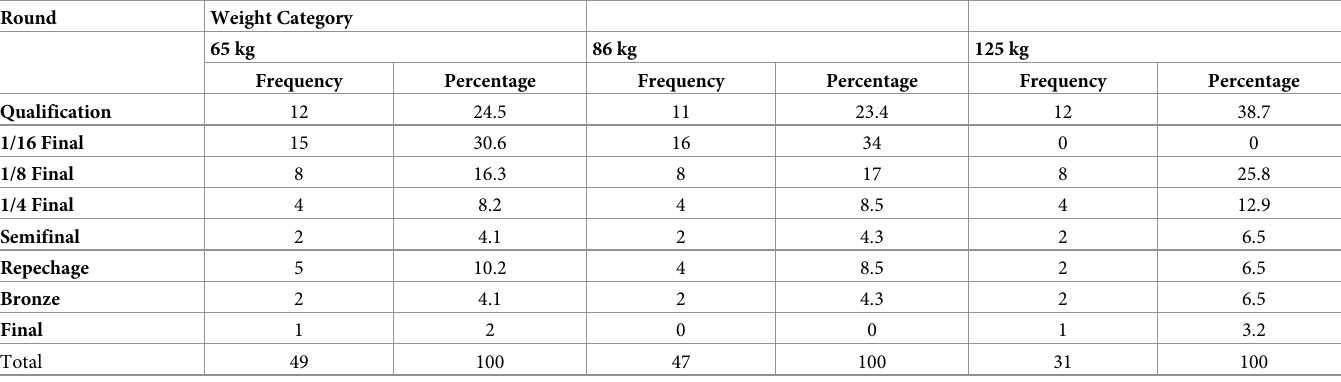
Table 1. Fights analyzed in the study regarding the weight category and competition